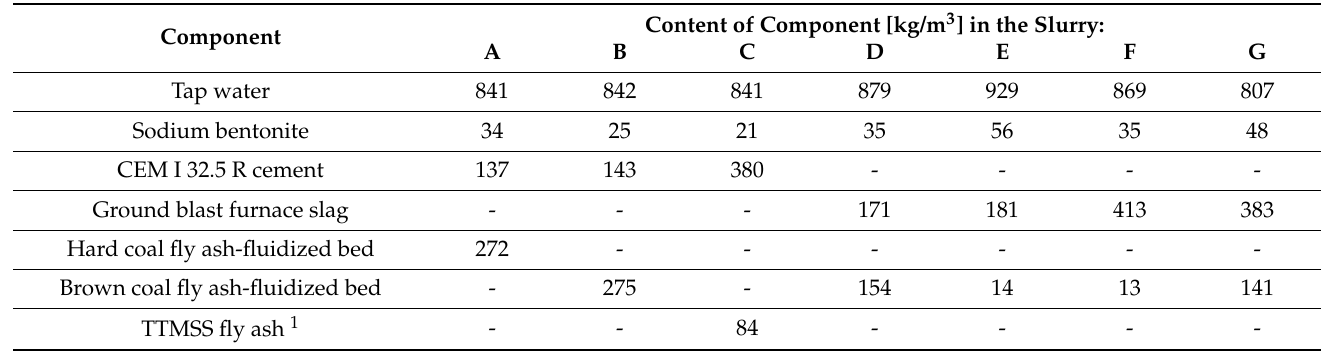
Table 1. Compositions of tested hardening